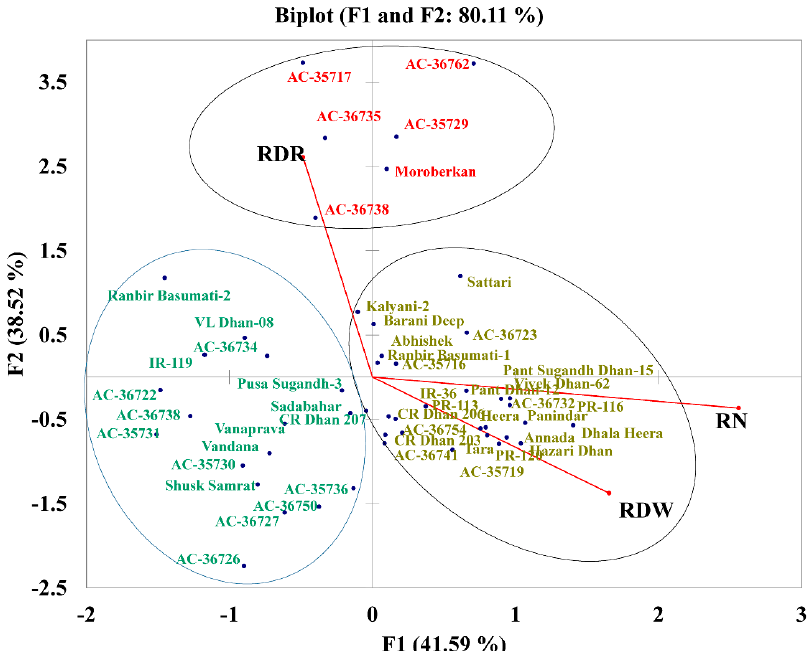
Figure 6. Factorial plans with two principal components representing the ratio of deep rooting (RDR), total number of roots (RN), and root dry weight (RDW) averaged over three replications of 49 rice genotypes under drought stress conditions. The variance explained by each dimension is shown as a percentage of the total variance.